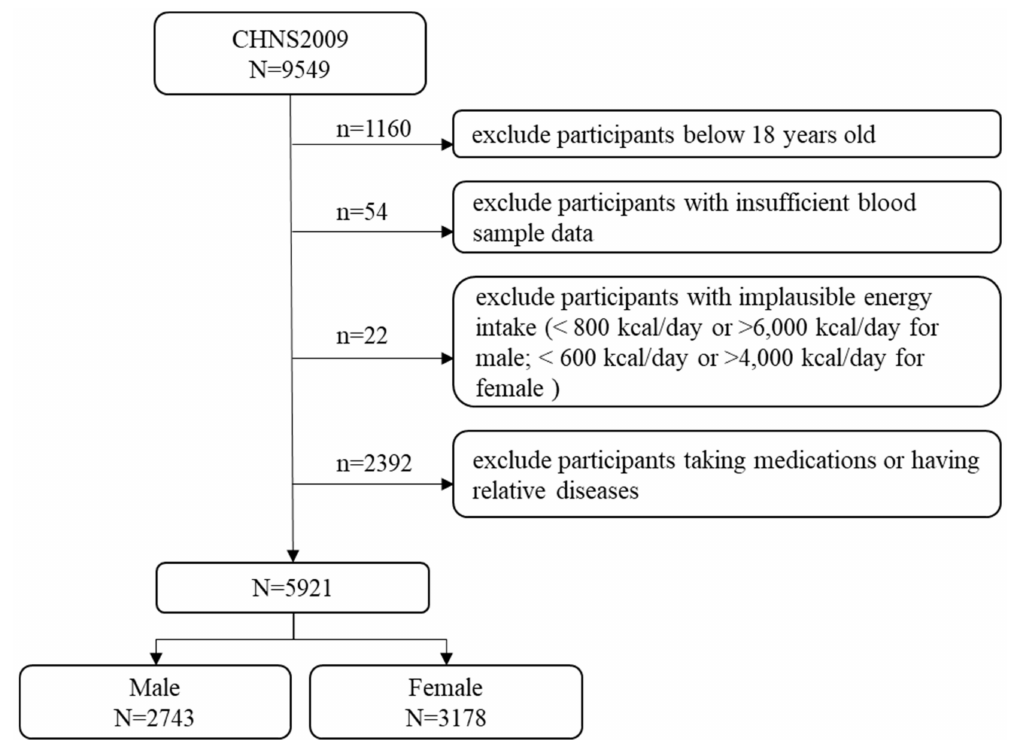
Figure 1. Selection process for the study population in the 2009 China Health and Nutrition Survey